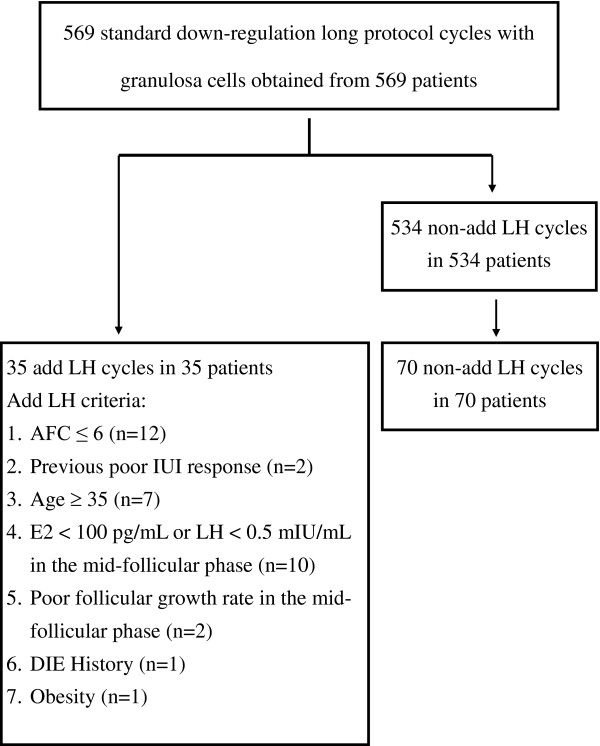
Flow diagram of 539 patients who attended the case-control study.